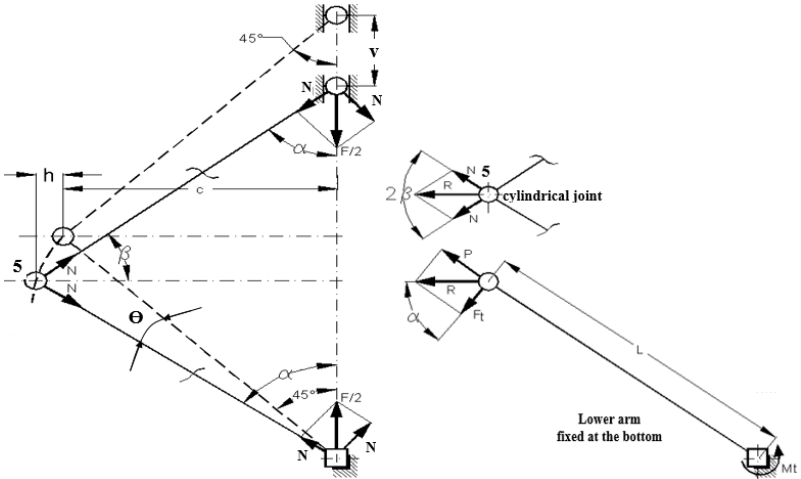
Figure 5. Representation of reaction forces in kinematic couplings and joints.